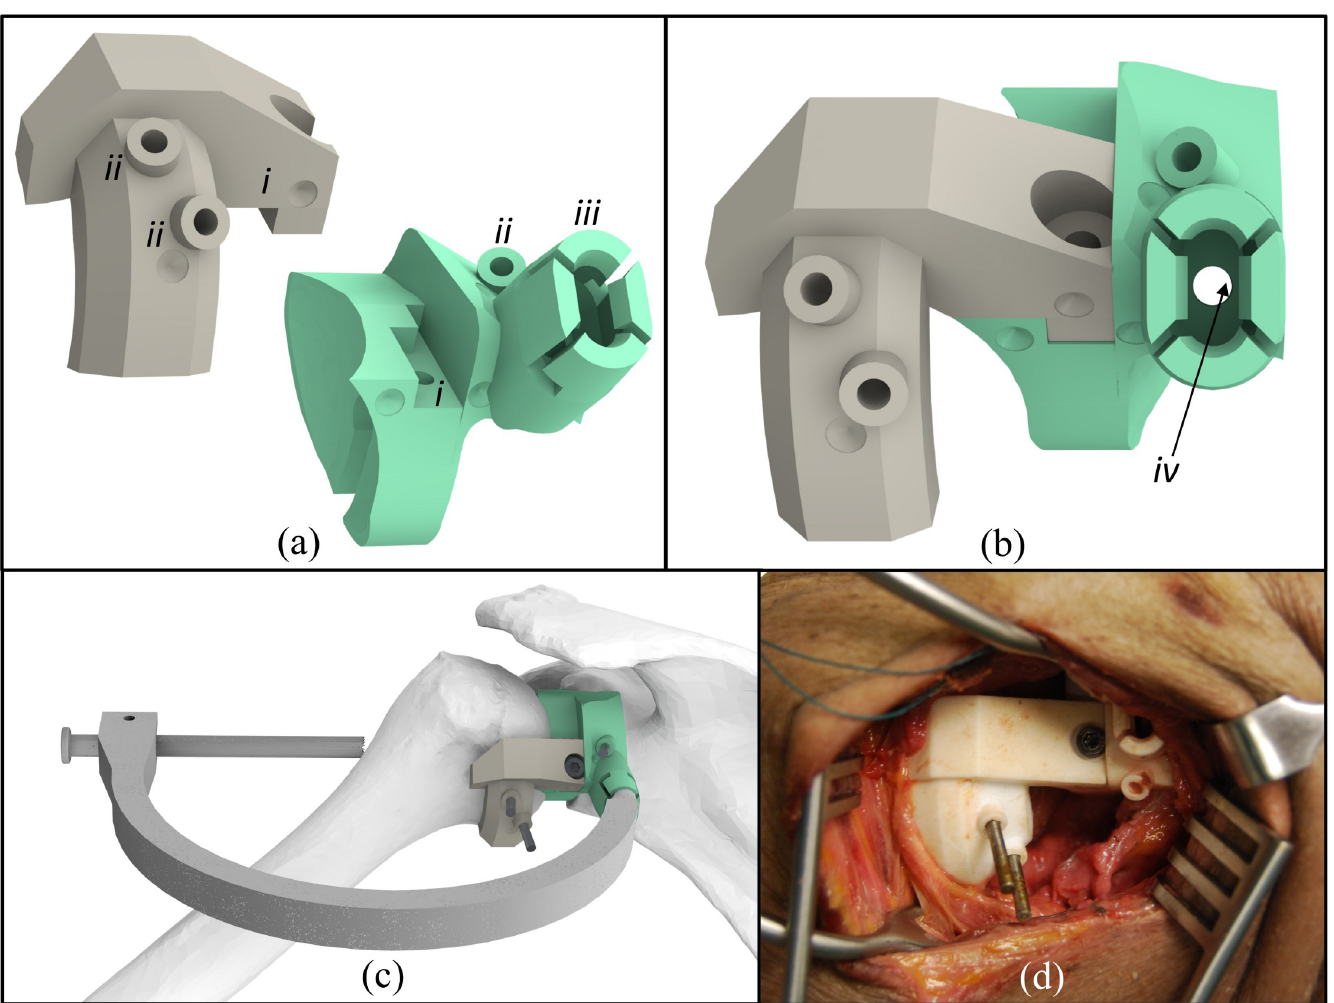
Fig 2. Computer renderings and photo of two-sided minimally invasive PSG. (a) Two PSG components from posterior-inferior view before being connected together with critical features including inter-lock mechanism (i), fixation pin holes (ii), and a standardized snap-fit feature for drill guide attachment (iii). (b) Posterior view with components connected showing hole used to guide creation of reference mark on glenoid rim (iv). (c) PSG registered to the humerus and scapula, such that they are placed in a pre-operatively planned pose with attached c-shaped drill guide that enables simultaneous trans-humeral and glenoid guide hole creation, with fixation pins inserted through guides into underlying bone, and a bolt rigidly fixing the patient specific guide components together, (d) photo showing PSGs registered to bones within posterior muscle splitting surgical approach.